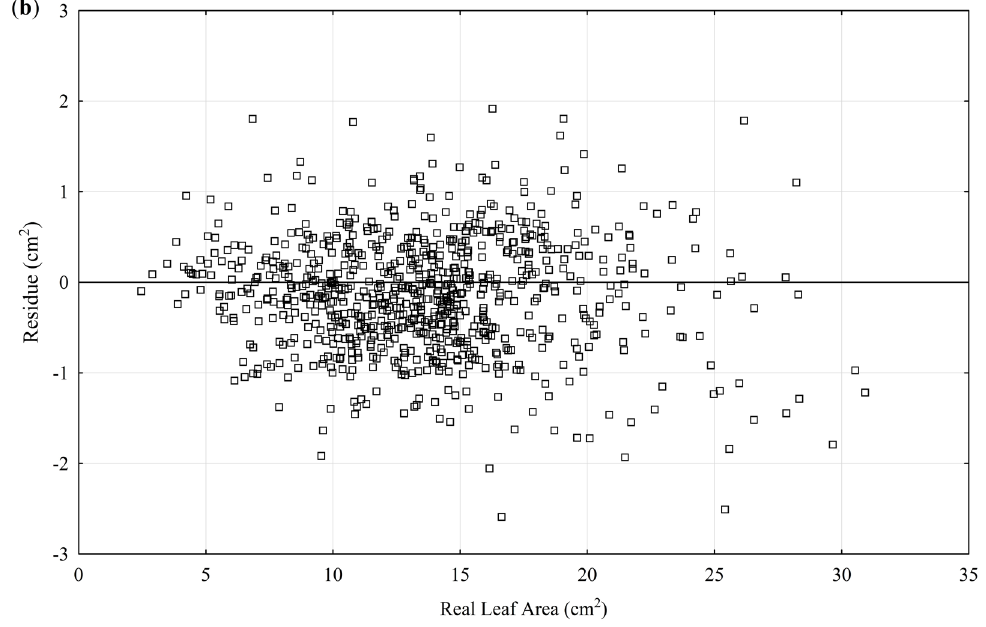
Figure 2b - Model residue - value estimated less real value of leaf area - for each leaf from the 800 leaves of Crotalaria juncea used to validate the